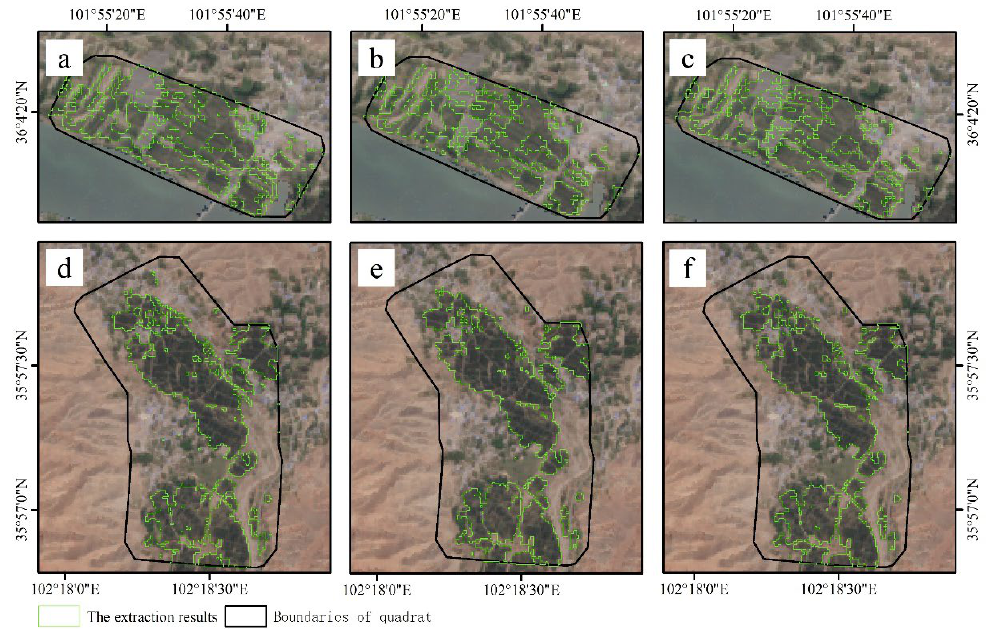
Figure 9. Winter wheat extraction results under optimal thresholds of the two quadrats. ( a ) Extraction results of quadrat 1 in Plan A; ( b ) Extraction results of quadrat 1 in Plan B; ( c ) Extraction results of quadrat 1 in Plan C; ( d ) Extraction results of quadrat 2 in Plan A; ( e ) Extraction results of quadrat 2 in Plan B; ( f ) Extraction results of quadrat 2 in Plan C.